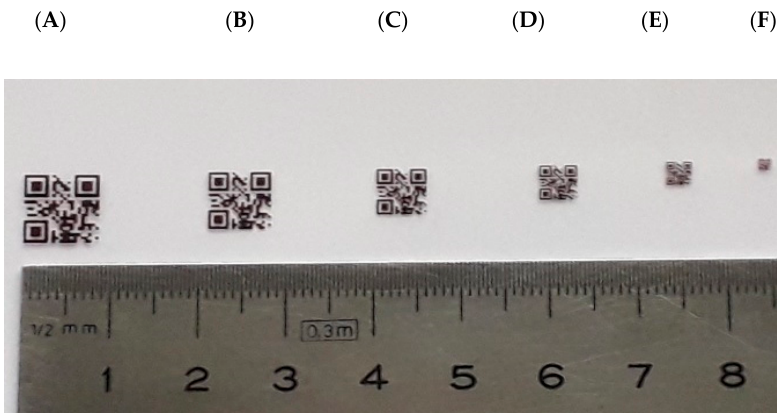
Figure 7. Masks used for 2D data spatial modulation of the eye ‐ safe beams: ( A ) 8 mm × 8 mm, ( B ) 7 mm × 7 mm, ( C ) 5.5 mm × 5.5 mm, ( D ) 4 mm × 4 mm, ( E ) 2.5 mm × 2.5 mm and ( F ) 1.25 mm × 1.25 mm.